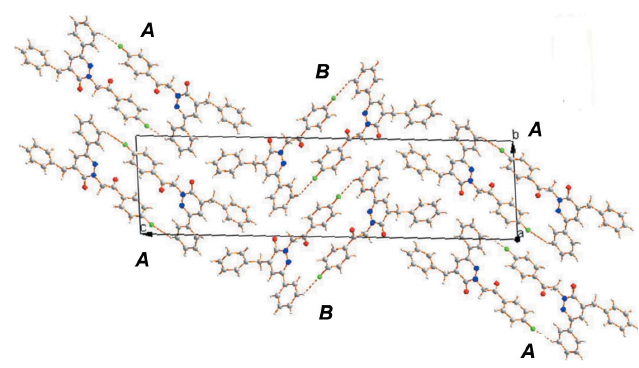
Figure 3 A view along the a axis of the crystal packing of the title compound. The